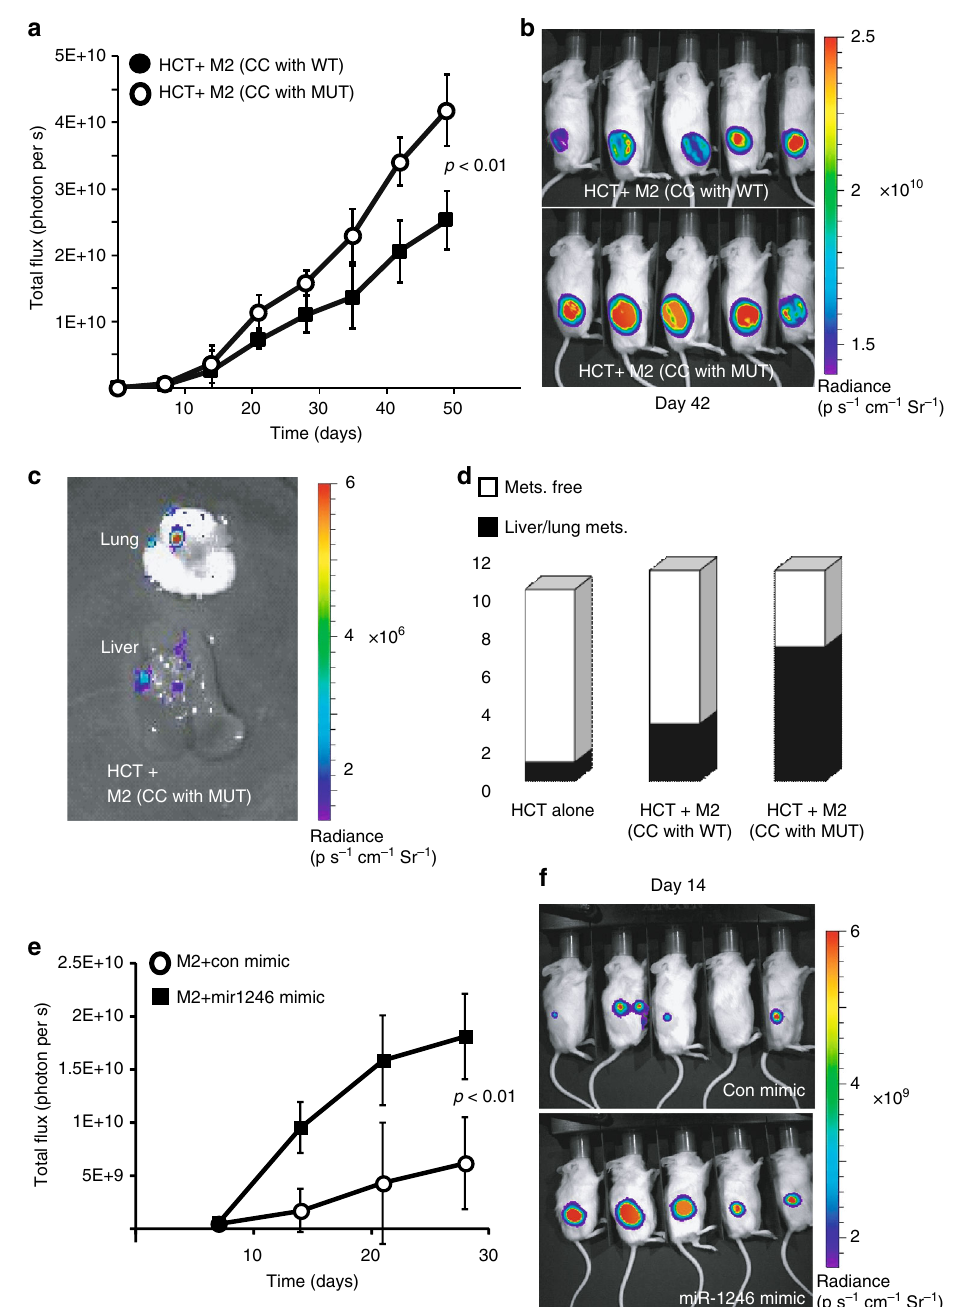
Fig. 4 miR-1246 is associated with mutp53 and plays a role in reprogramming TAMs. a , b M2 macrophages were co-cultured with either mutp53 or WT p53 HCT116 cells for 6 days. Subsequently, 10 5 reprogrammed macrophages were mixed with 5 × 10 5 fresh HCT116 WT cells (carrying a luciferase vector) and co-injected subcutaneously into NOD-SCID mice. Each group consisted of 10 or 11 animals. Tumor development was monitored weekly. c , d On day 56 of the experiment described in a , b , mice were killed and their liver and lungs were monitored for metastatic foci ( c ), and the number of organs observed with metastases were compared with a group of mice injected with HCT116 cells alone ( d ). e , f M2 macrophages were transfected with LNA-miR-1246 mimic and compared with an equivalent control vector. Three days later, the transfected macrophages were mixed with luciferase expressing HCT116 cells and co-injected subcutaneously to the back of NOD-SCID mice (HCT116 + M2 with control mimic, n = 5, HCT116 + M2 with miR1246 mimic, n = 5). Mice were monitored weekly for tumor growth using an IVIS imager ( e ) and luminescent fl uxes were quanti fi ed ( f ). Error bars represent standard